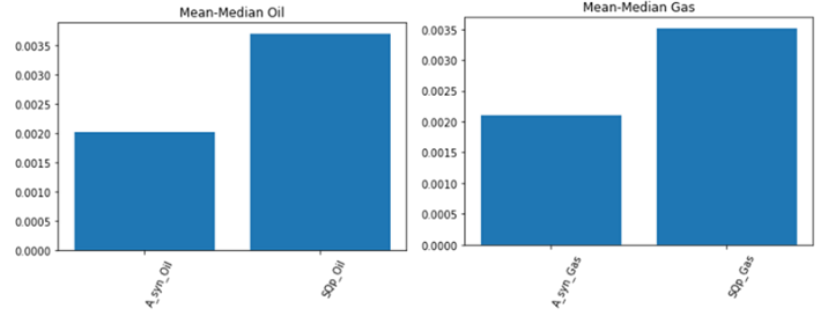
Figure 6. Mean–median score analysis on oil & gas Figure 6. Mean – median score analysis on oil & gas condition.